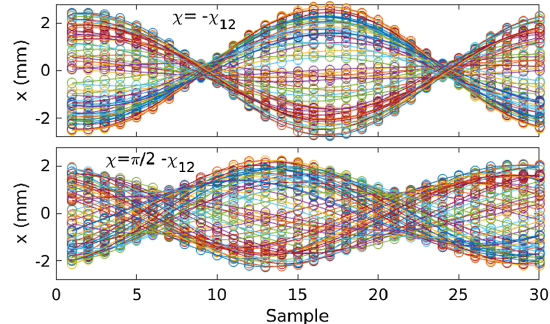
FIG. 4. Comparison of horizontal orbit samples phase shifts between the two correctors set to χ ¼ − ψ χ ¼ π − ψ (bottom) for the SPEAR3 example. Each sample 2 x; 12 is an orbit with 57